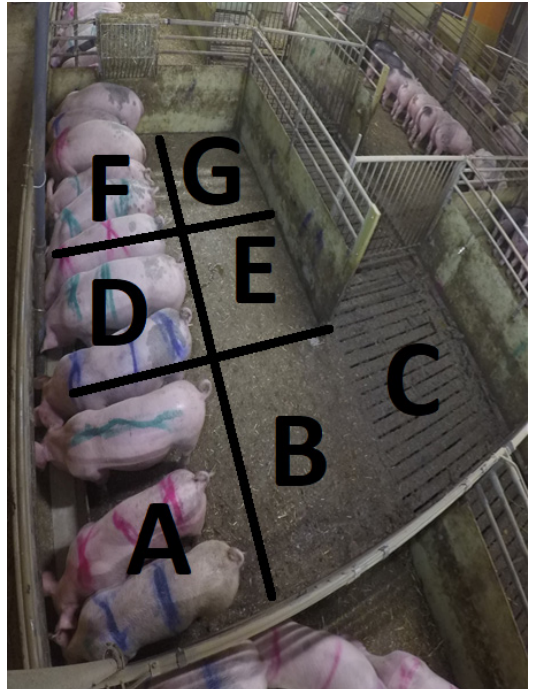
Figure 1. The design of the pen including the position of the straw rack. The pigs were individually marked for identification during observations. The letters (A–G) illustrates the pen division in zones for the recording of pen utilisation.